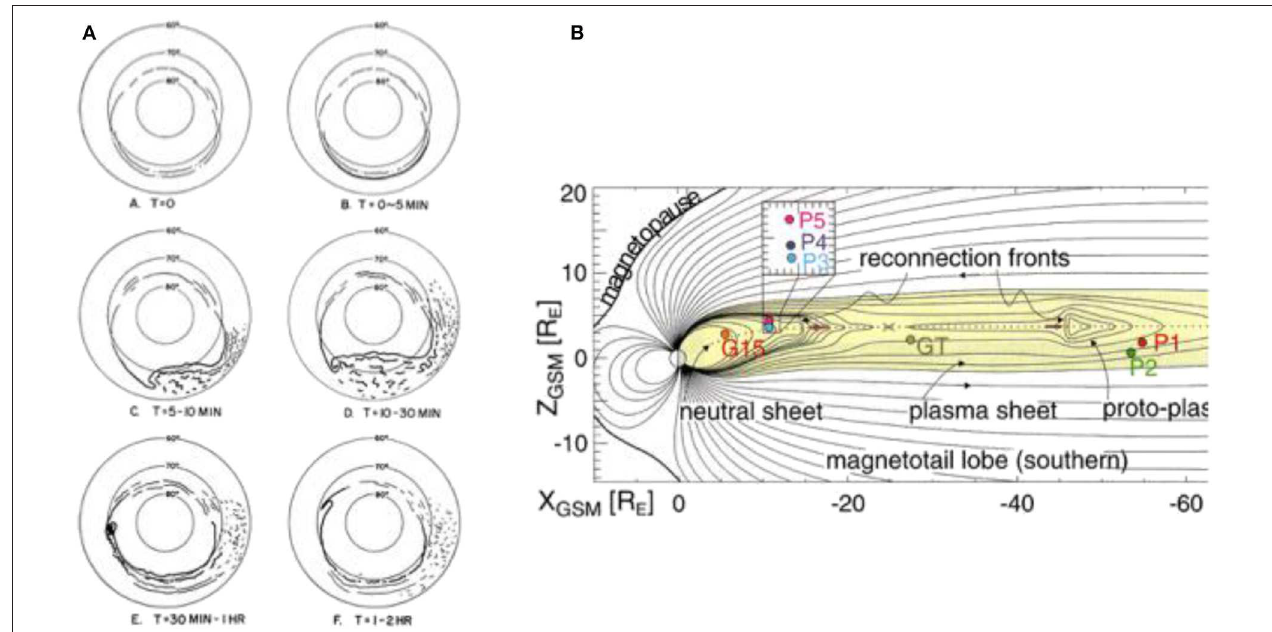
FIGURE 5 | A global view. (A) A schematic illustration of the development of the expansion phase of the auroral substorms (adopted from Figure 1 in Akasofu, 1964; permission from Elsevier Ltd.). (B) The magnetic field configuration in the magnetotail during a substorm, showing magnetic reconnection (adopted from Figure 1 in Angelopoulos et al., 2008; permission from the American Association for the Advancement of Science).